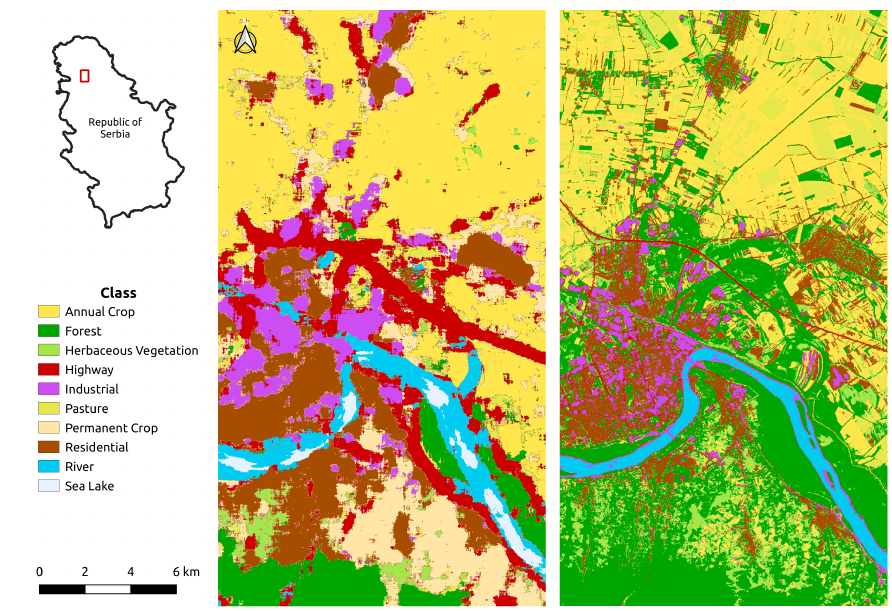
Figure 6. LC map created using the CNN vs. manual